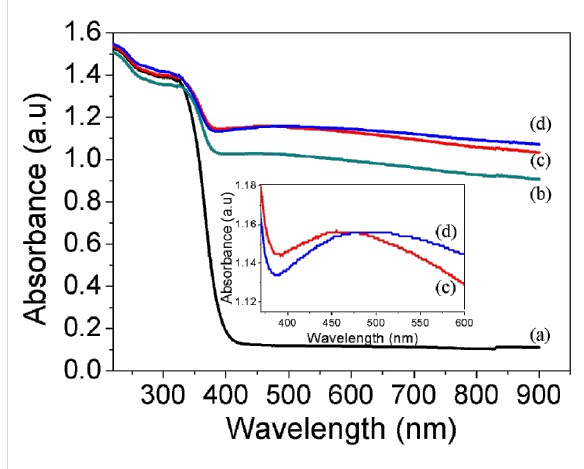
Figure 5: Adsorption–desorption isotherm of 0.5 wt % Pd/TiO 2 and the inset is the pore size distribution.